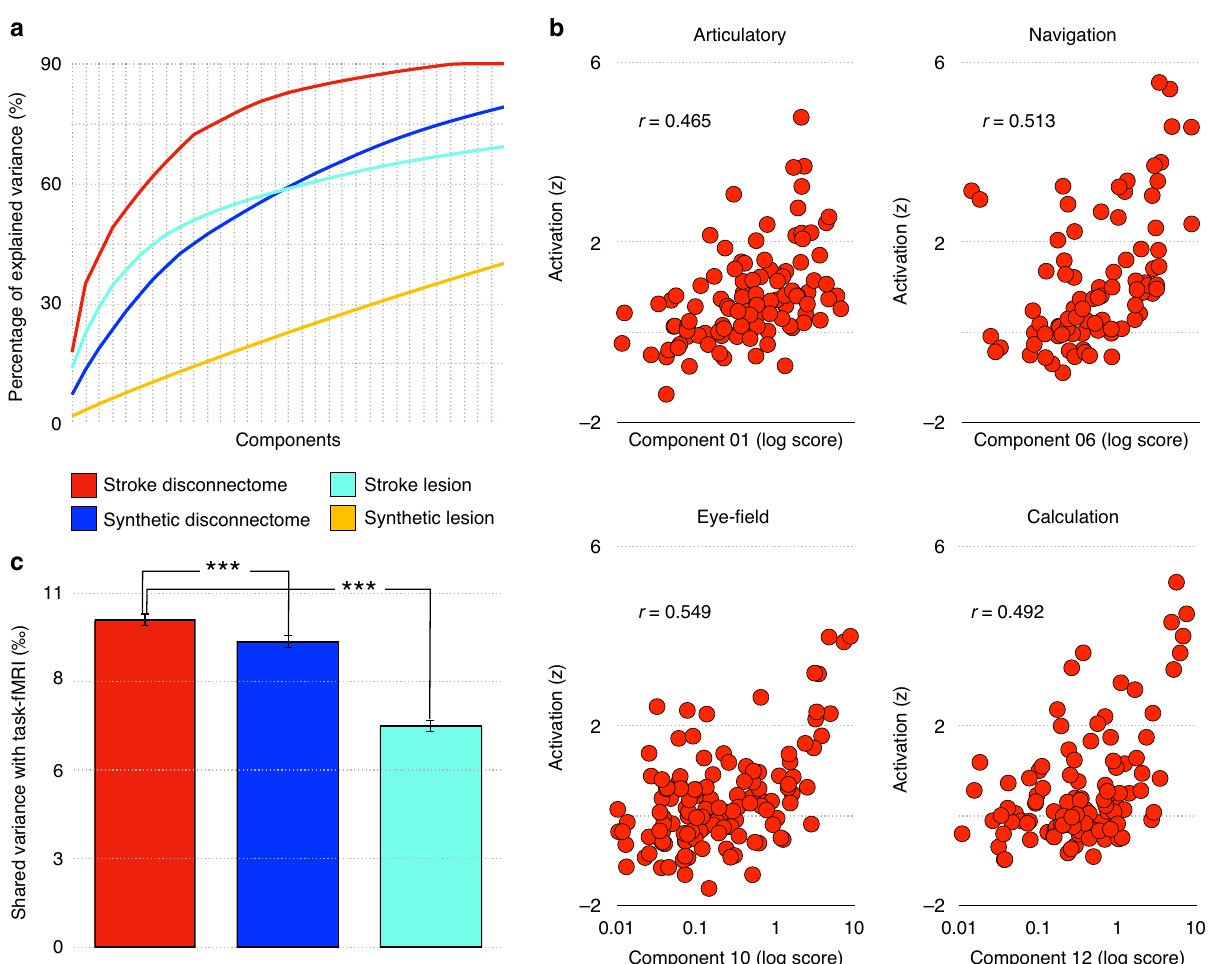
Fig. 2 Principal components of stroke and their relationship to function. a The cumulative percentage of explained variance for the fi rst 30 components of the stroke disconnectome (red), synthetic disconnectome (blue), stroke lesion (turquoise), synthetic stroke lesion (yellow) distribution. By percentage of variance here we mean the R 2 between the original lesion or disconnectome and the lesion or disconnectome reconstructed from the linear combination of the components. b Four representative examples of the correlation between stroke disconnectome components and task-related functional MRI meta- analytic activations. c Average percentage of variance explained by task-related functional MRI meta-analytic activations (590 functions) for the stroke disconnectome (red, 46 components), synthetic disconnectome (blue, 53 components) and stroke lesion distribution (turquoise, 50 components). *** p < 0.001 two-tailed, bootstrapped ( n = 1000) independent sample t -test (two comparisons, p = 0.00099 in both cases). Data are presented as mean values and error bars indicate 95% con fi dence intervals. Source data for this bar chart are available as Supplementary Data